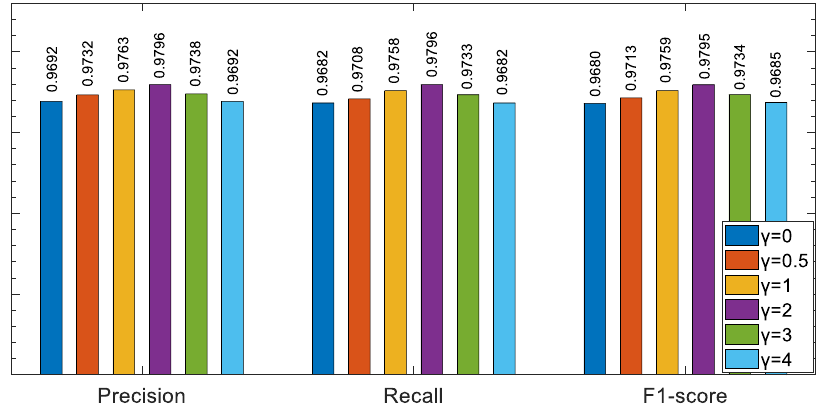
Figure 11. The comparison of model performance under different γ .